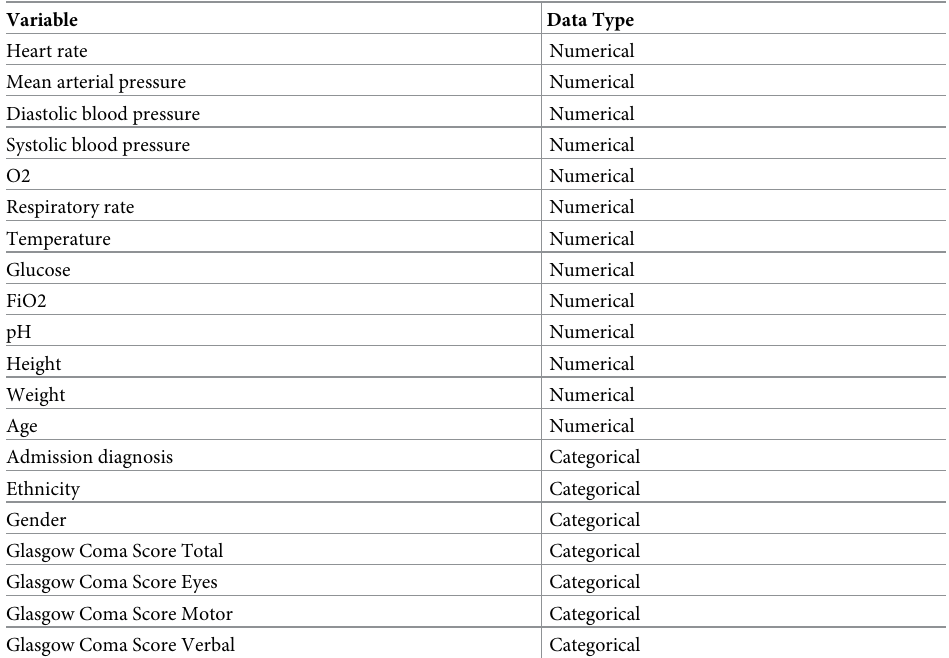
Table 2. Selected variables for all the four tasks.